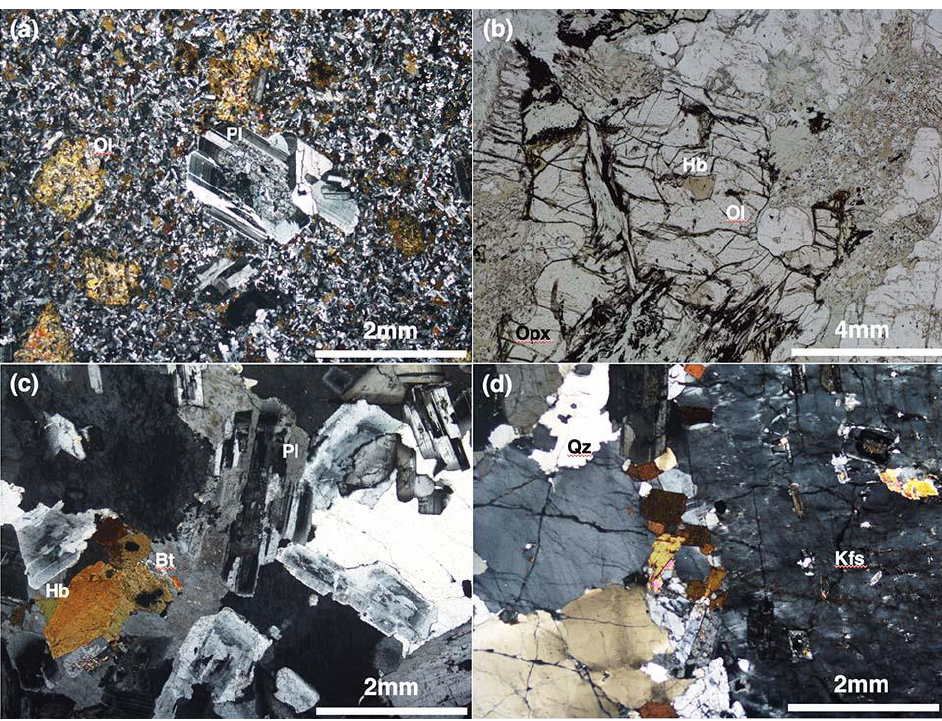
Figure 4. Photomicrographs of the study samples. ( a ) Fn-gabbro. ( b ) CM-gabbro. ( c ) Granodiorite. ( d ) Granite. Pl: plagioclase, Qz: quartz, Kfs: K-feldspar, Ol: olivine pseudomorph replaced by fine-grained minerals probably smectite, Opx: orthopyroxene, Hb: hornblende, Bt: biotite.